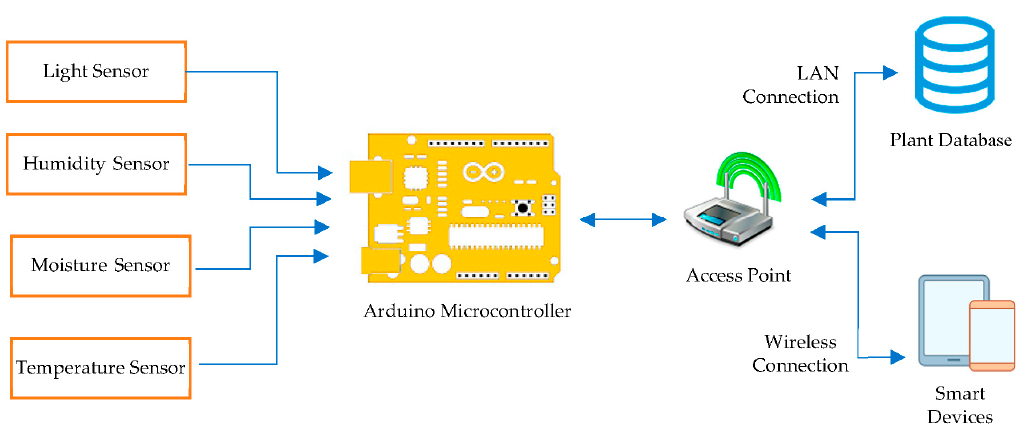
Figure 3. Hardware integration design of the smart irrigation system.